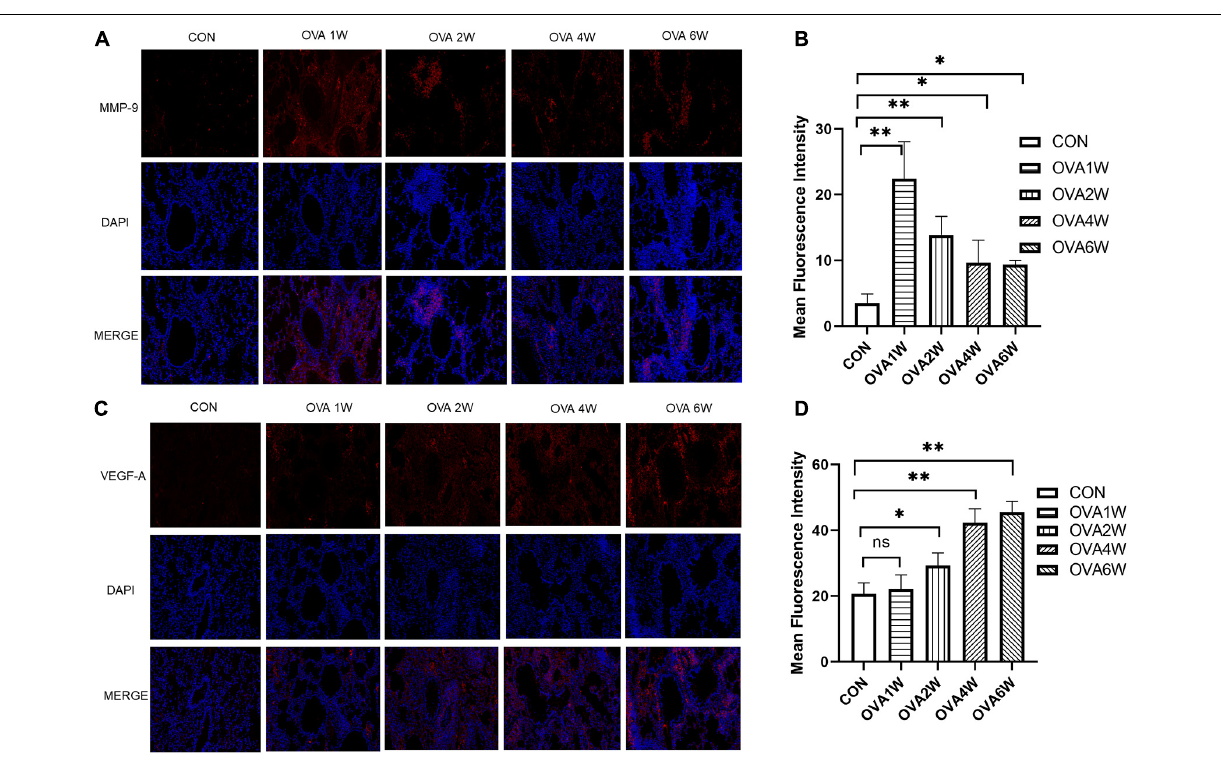
Frontiers in Microbiology |